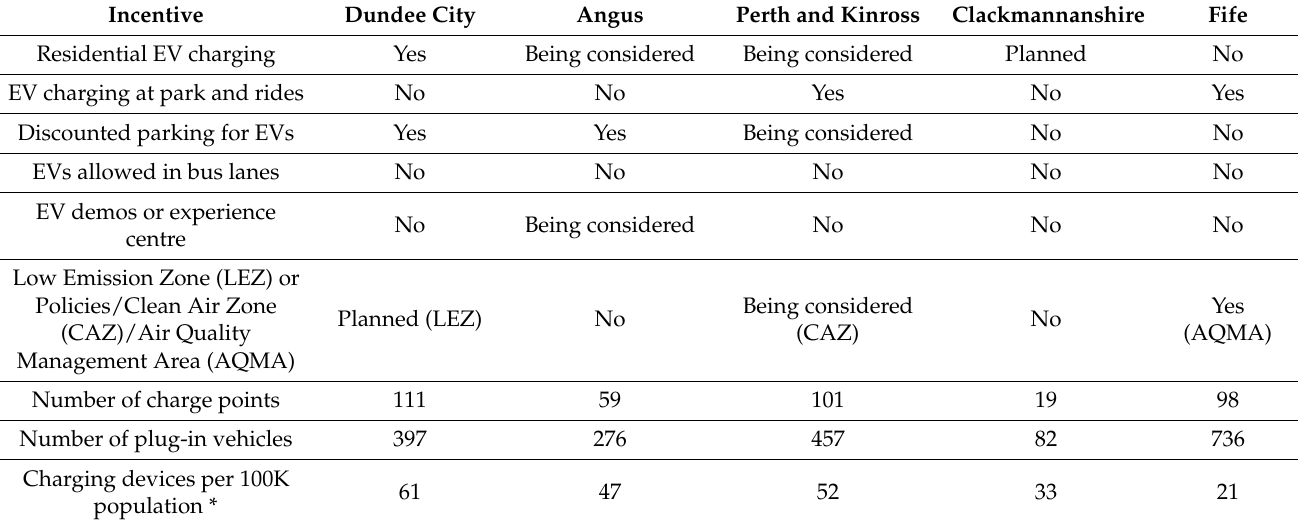
Table 2. Incentives comparison—Dundee and neighbouring local